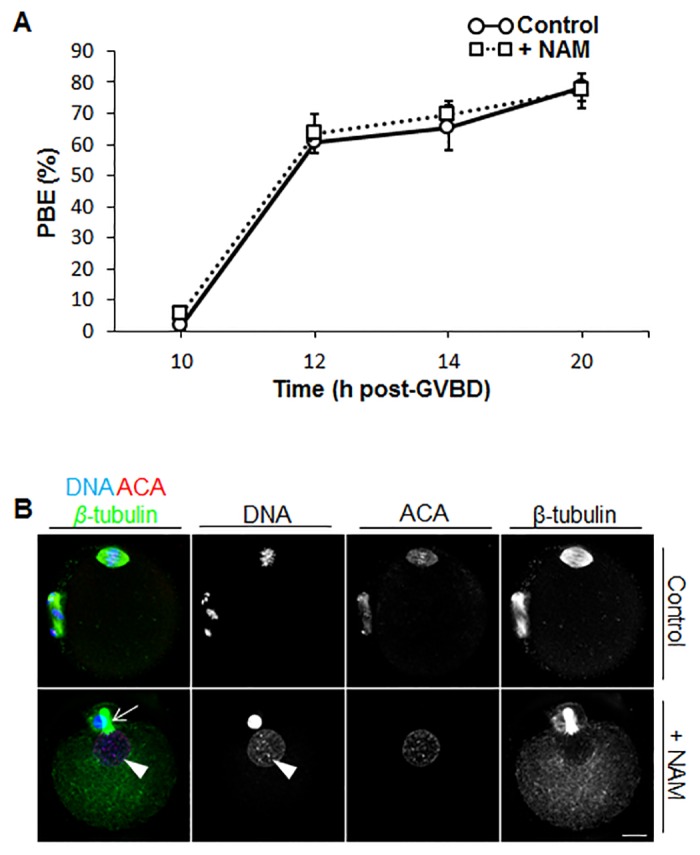
Polar body exclusion (PBE) rates and chromosome and spindle morphology in control and NAM-treated oocytes.(A) PBE rates were scored for control and NAM-treated oocytes at 10 h (n = 103 control and n = 90 NAM), 12 h (n = 104 control and n = 64 NAM), 14 h (n = 122 control and n = 60 NAM) and 20 h (n = 169 control and n = 131 NAM) post-GVBD. Numbers of oocytes are pooled data from 3 or more replicate experiments. Data are mean ± SEM. (B) Control and NAM-treated oocytes that exhibited a clear polar body were immunostained for chromosomes (DNA), kinetochores (ACA) and spindle microtubules (β-tubulin). Note the presence of the central spindle (white arrow) and decondensed chromatin enclosed within a nuclear structure (white arrow head) following NAM treatment. Scale bars = 10 μm.